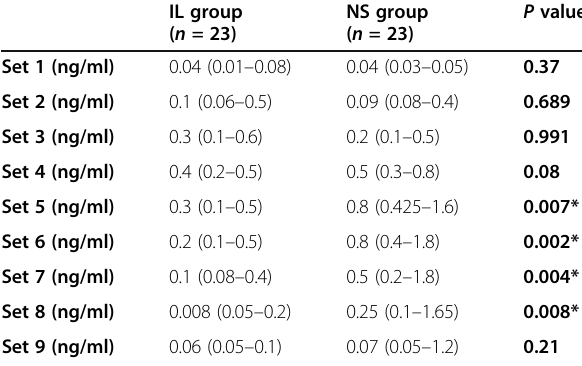
Table 4 Troponin level measurement every 6